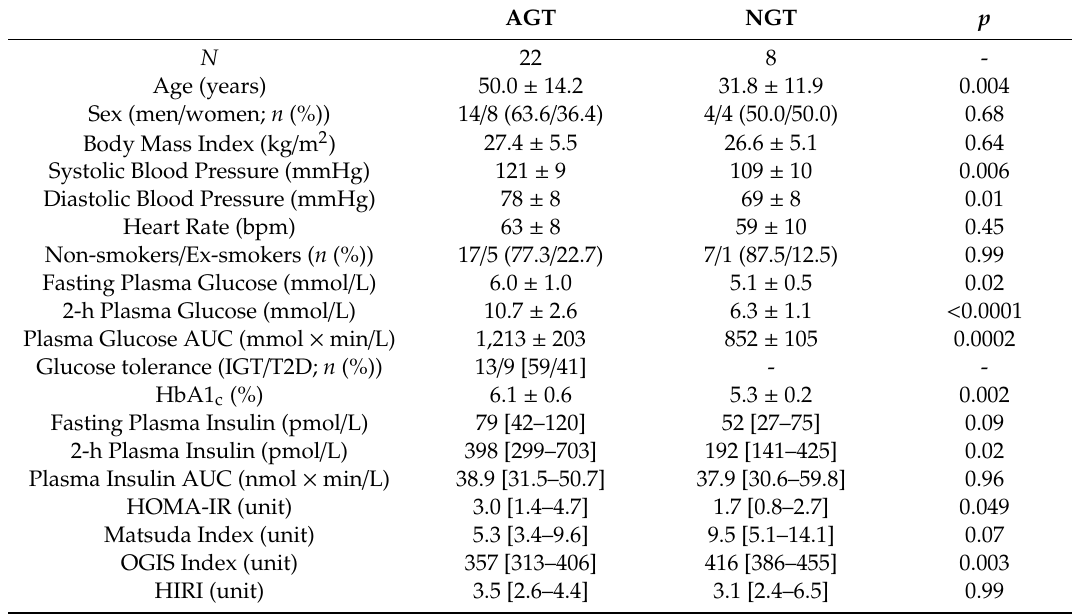
Table 1. Clinical and metabolic characteristics of study participants.